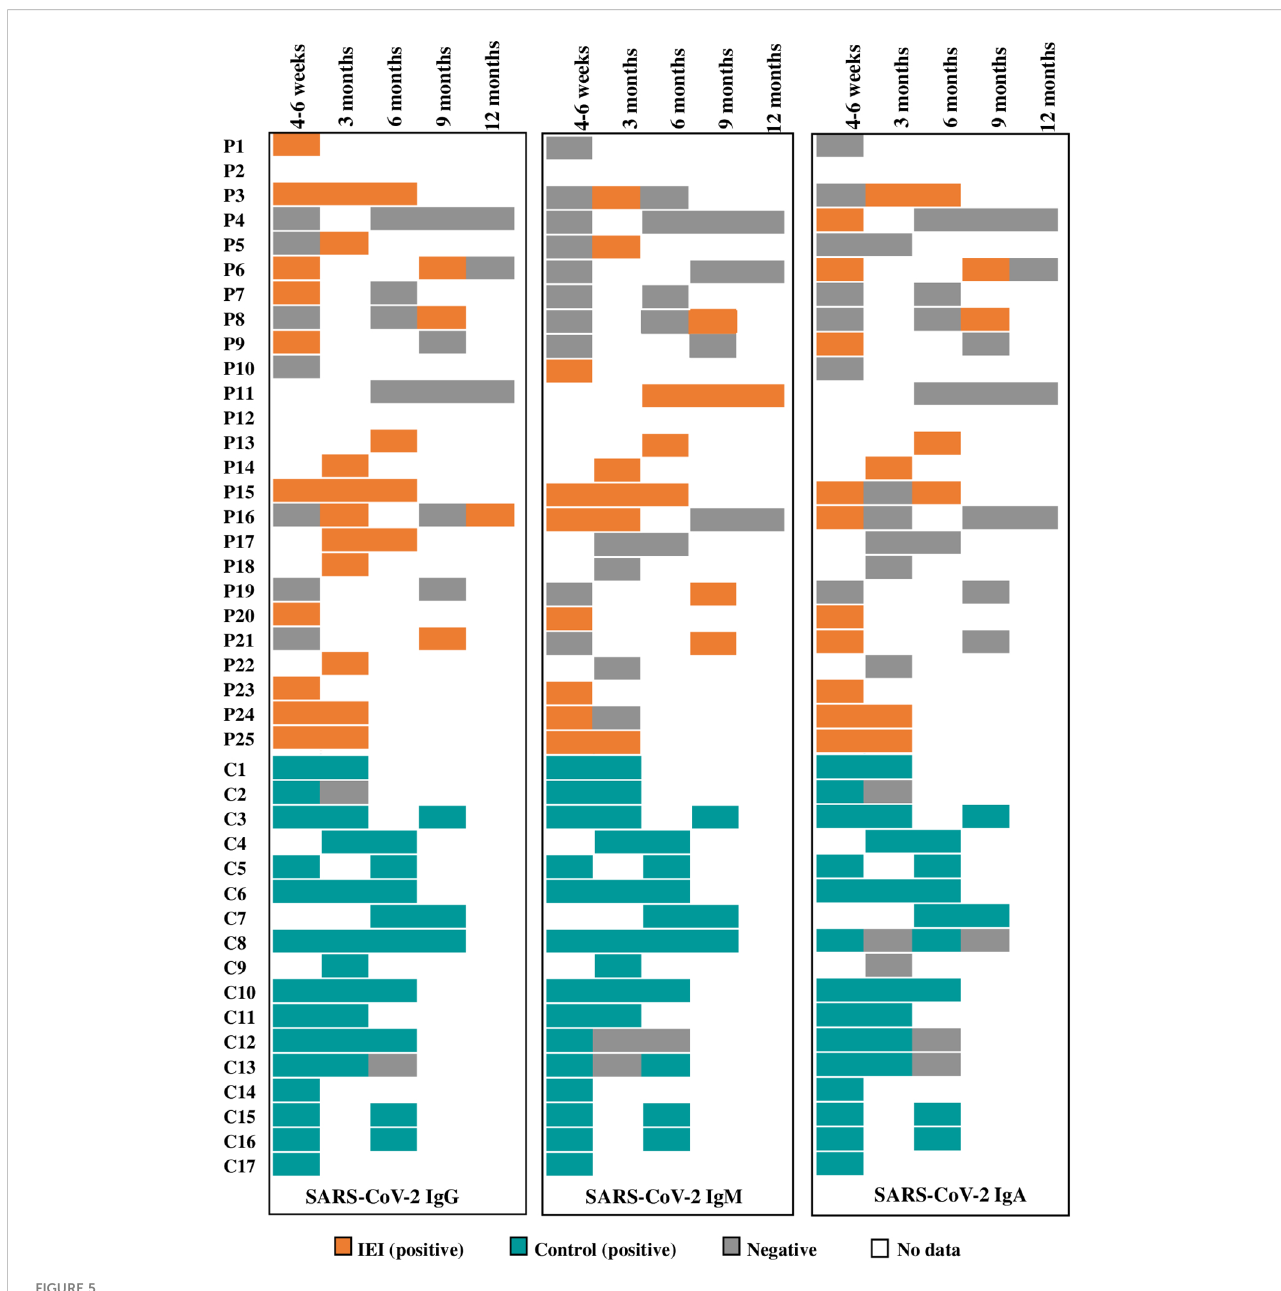
FIGURE 5 Patient by patient representation of SARS-CoV-2 positive and negative serologies during the